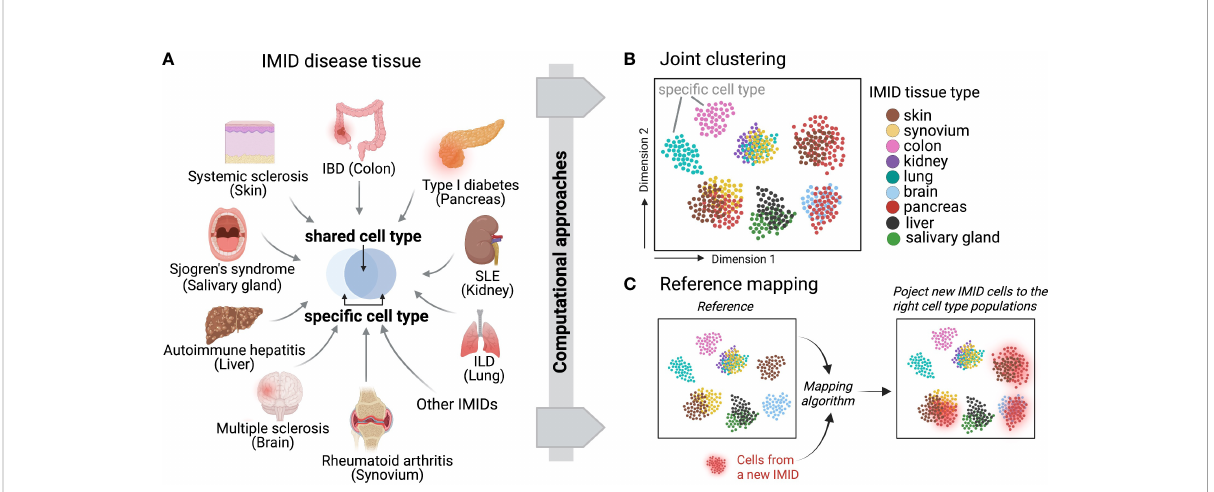
FIGURE 3 Across IMID single-cell integrative analysis. (A) Multiple IMIDs (organ systems) where in fl ammatory and pathogenic cells display both heterogeneity and similarity between tissue types and within disease contexts. Computational approaches can be deployed to disentangle the shared and speci fi c pathways between IMIDs while also controlling for tissue heterogeneity. Two main computational frameworks include (B) integrative and joint clustering analysis and (C) reference mapping approach. (B, C) indicate the low-dimensional projections of cells across